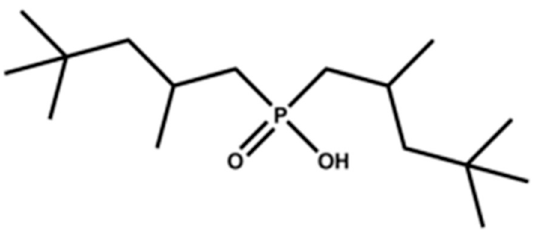
Figure 1. Chemical structure of bis(2.4.4- trimethylpentyl) phosphinic acid (Cyanex